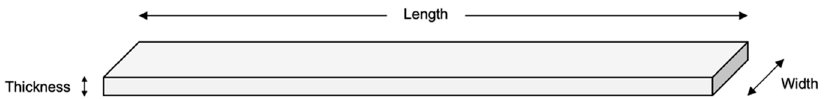
Figure 1. Illustrated specimen indicating the dimensions evaluated: length, width, and thickness.